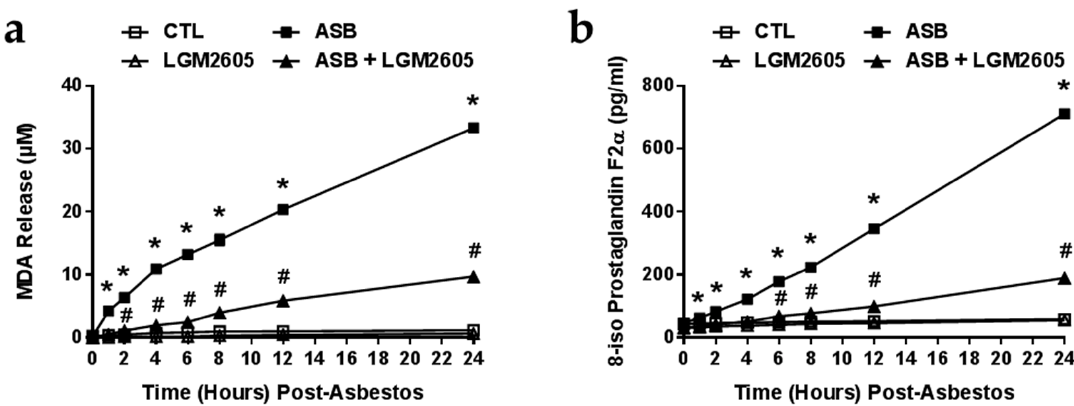
Figure 4. LGM2605 Prevents Oxidative Cell Damage and the Release of MDA and 8-IsoP. Elicited murine peritoneal macrophages were plated in a 6-well plate (2 × 10 6 cells/well) and exposed to 50 µM synthetic SDG (LGM2605) 4-h prior to exposure to sterile UICC crocidolite (SPI Supplies) asbestos fibers (20 µg/cm 2 ). The levels of ( a ) MDA and ( b ) 8-iso Prostaglandin F2a were determined in the cell culture medium at 0, 1, 2, 4, 6, 8, 12 and 24-h post asbestos exposure. Data are presented as